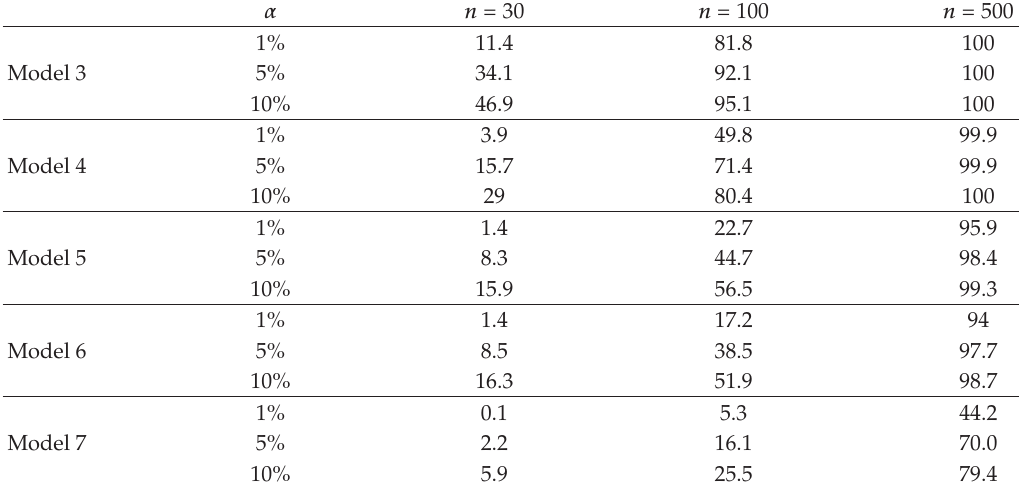
Table 2: Empirical powers (cid:8) % (cid:9)